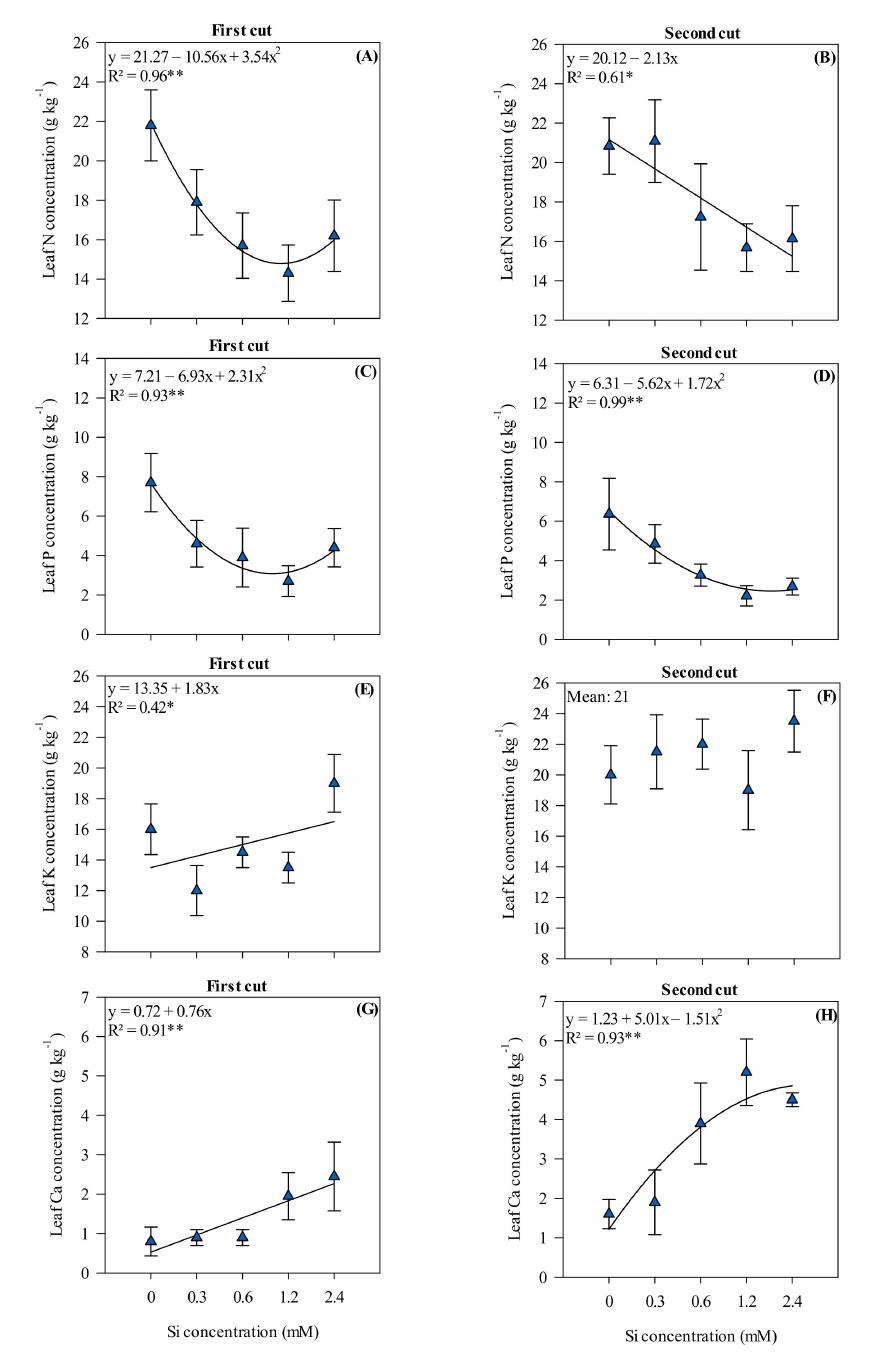
Figure 4. Leaf N concentration in the first ( A ) and second cut ( B ), leaf P concentration in the first ( C ) and second cut ( D ), leaf K concentration in the first ( E ) and second cut ( F ), leaf Ca concentration in the first ( G ) and second cut ( H ) as a function of increasing Si concentrations in Xara é s palisadegrass. Error bars indicate the standard deviation of the mean ( n = 4). * and ** = significant at 5 and 1% probability by F test